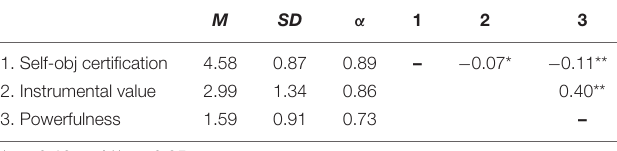
TABLE 7 | Correlations between variables: self-objectification, instrumental value, and powerfulness ( N = 650).